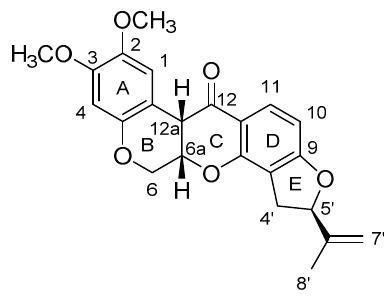
Figure 5. Structure of natural